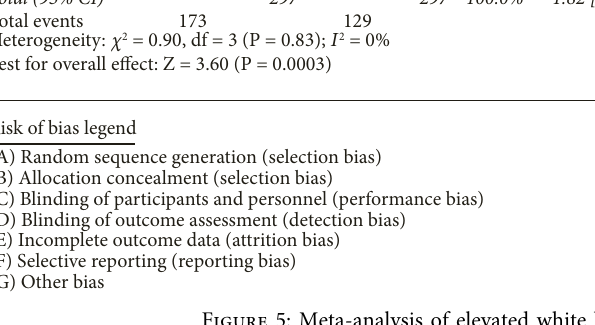
Figure 5: Meta-analysis of elevated white blood cell count between two